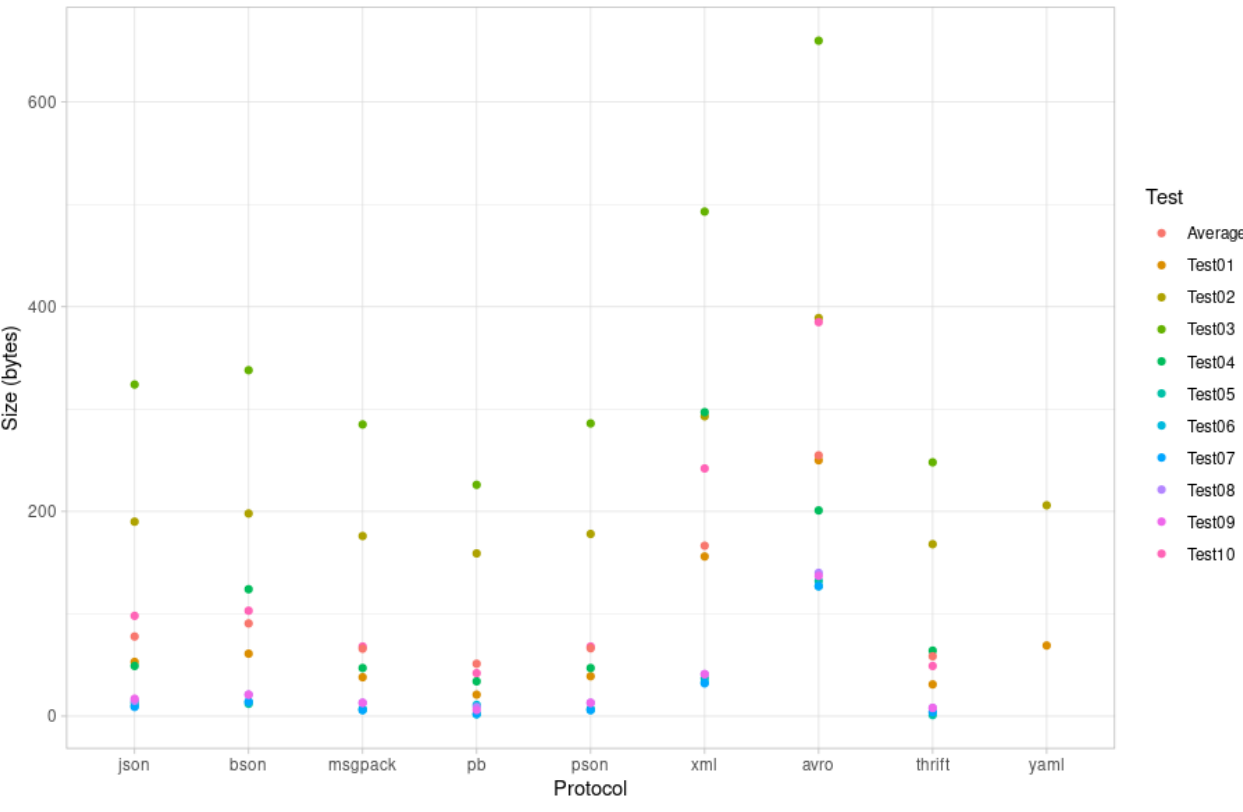
Figure 7. Protocol encoding